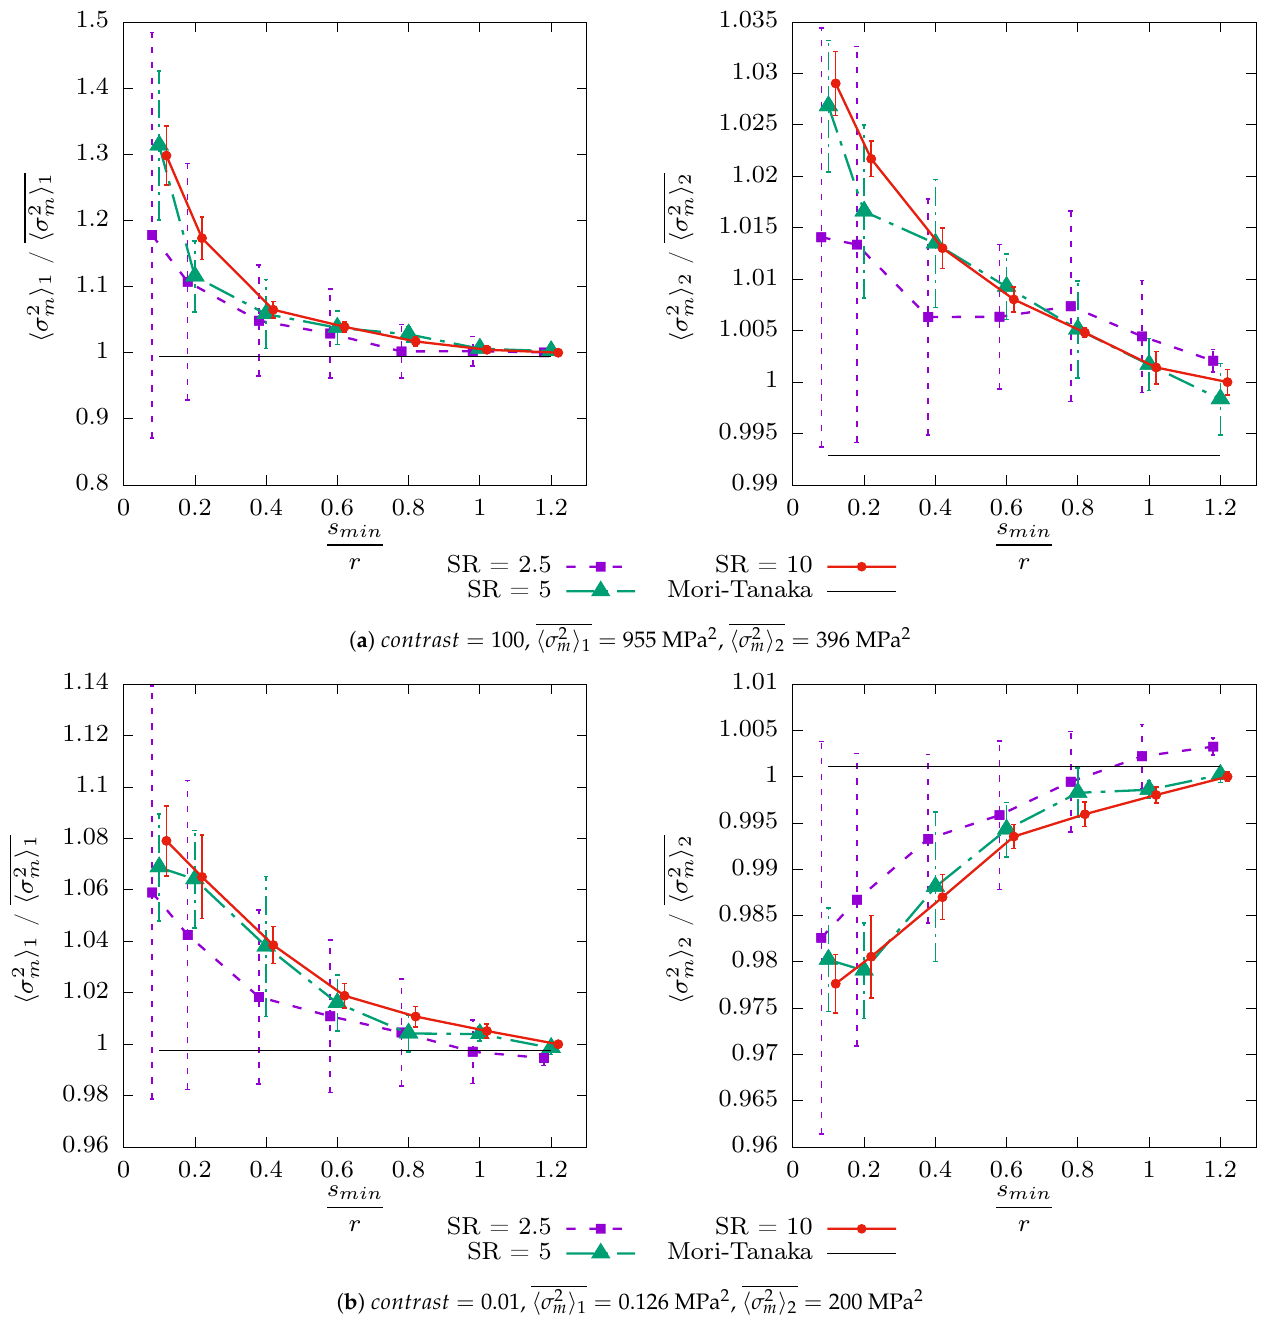
Figure 7. Mean values and standard deviations on the mean value for the second moment of hydrostatic stress by phase as a function of the packing parameter s min / r ( r = 10 µ m) for a volume fraction of inclusions f v = 13.4 %. For clarity, the error bars and dots are slightly shifted around for each studied minimum